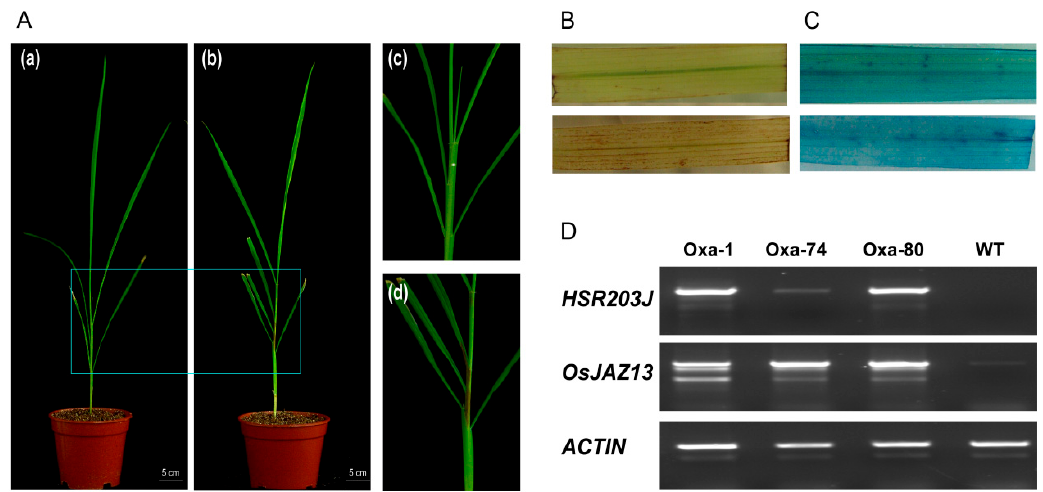
Figure 8. OsJAZ13a -overexpression plants develop spontaneous necrosis on the sheath, which accumulates ROS and high expression of hypersensitive response marker gene. ( A ) Necrotic spots on sheath of OsJAZ13a -overexpression plants indicated by WT ( a ) and Oxa ( b ). Scale bars = 5 cm. Magnified views of the WT ( c ) and Oxa ( d ) are shown in the right panels. The plants were grown in a greenhouse (25 ◦ C, 55–65% humidity, 14 h light / 10 h dark) for 30–45 days. ( B ) Detection of H 2 O 2 content in the leaves of OsJAZ13a -overexpression lines while lesion appearing on the sheath, WT (above) and Oxa (bottom). The brown region staining by DAB on leaves indicates the H 2 O 2 level. ( C ) Detection of PCD in the leaves of OsJAZ13a -overexpression lines. The blue spots on leaves by typan blue staining indicate cell death, WT (above) and Oxa (bottom). ( D ) Expression analysis of OsJAZ13 and hypersensitive response marker gene HSR203J by RT-PCR; RNA was extracted from leaves of OsJAZ13a -overexpression plants when lesion emerged in the sheath. ACTIN served as internal control. These experiments were performed for three independent biological repeats.